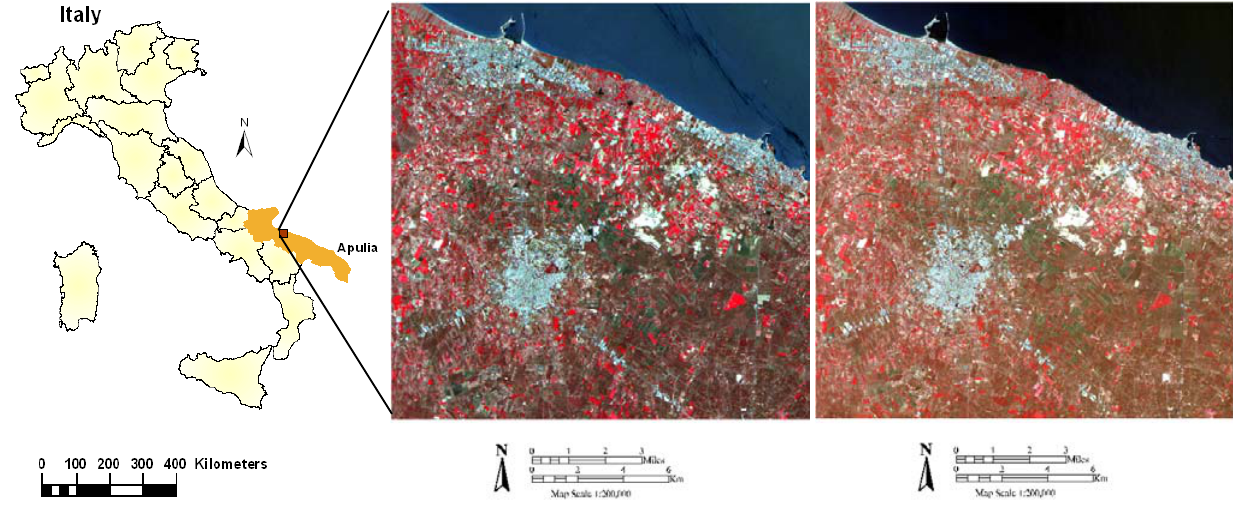
Figure 1. Location of the study area and original subsets of ASTER data: acquisition dates of 2003-06-24 (left) and 2007-07-14